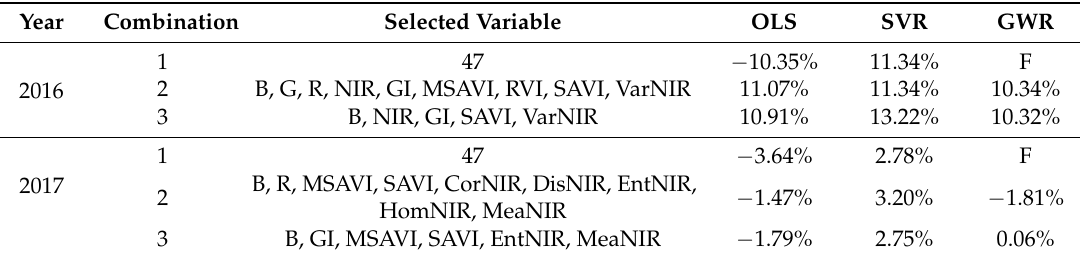
Table 6. Rice yield estimation in the first cultivations of 2016 and 2017 in Dapi.